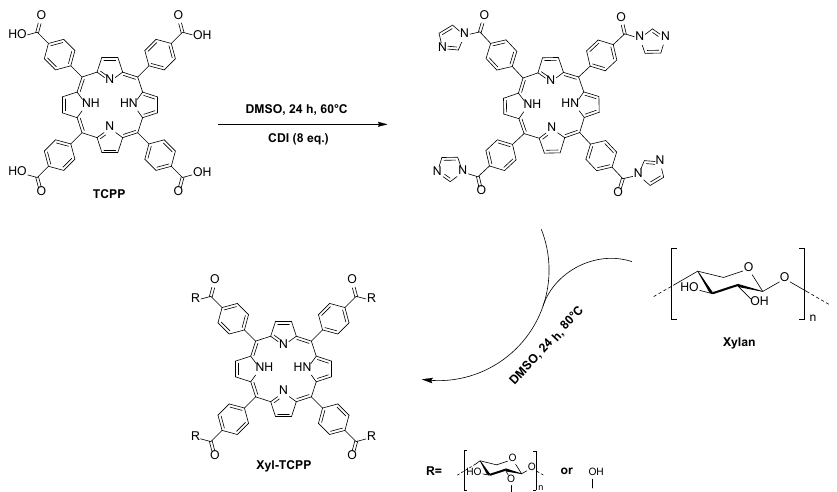
Figure 1. Synthesis of hydrogels by cross-linking xylan with TCPP .